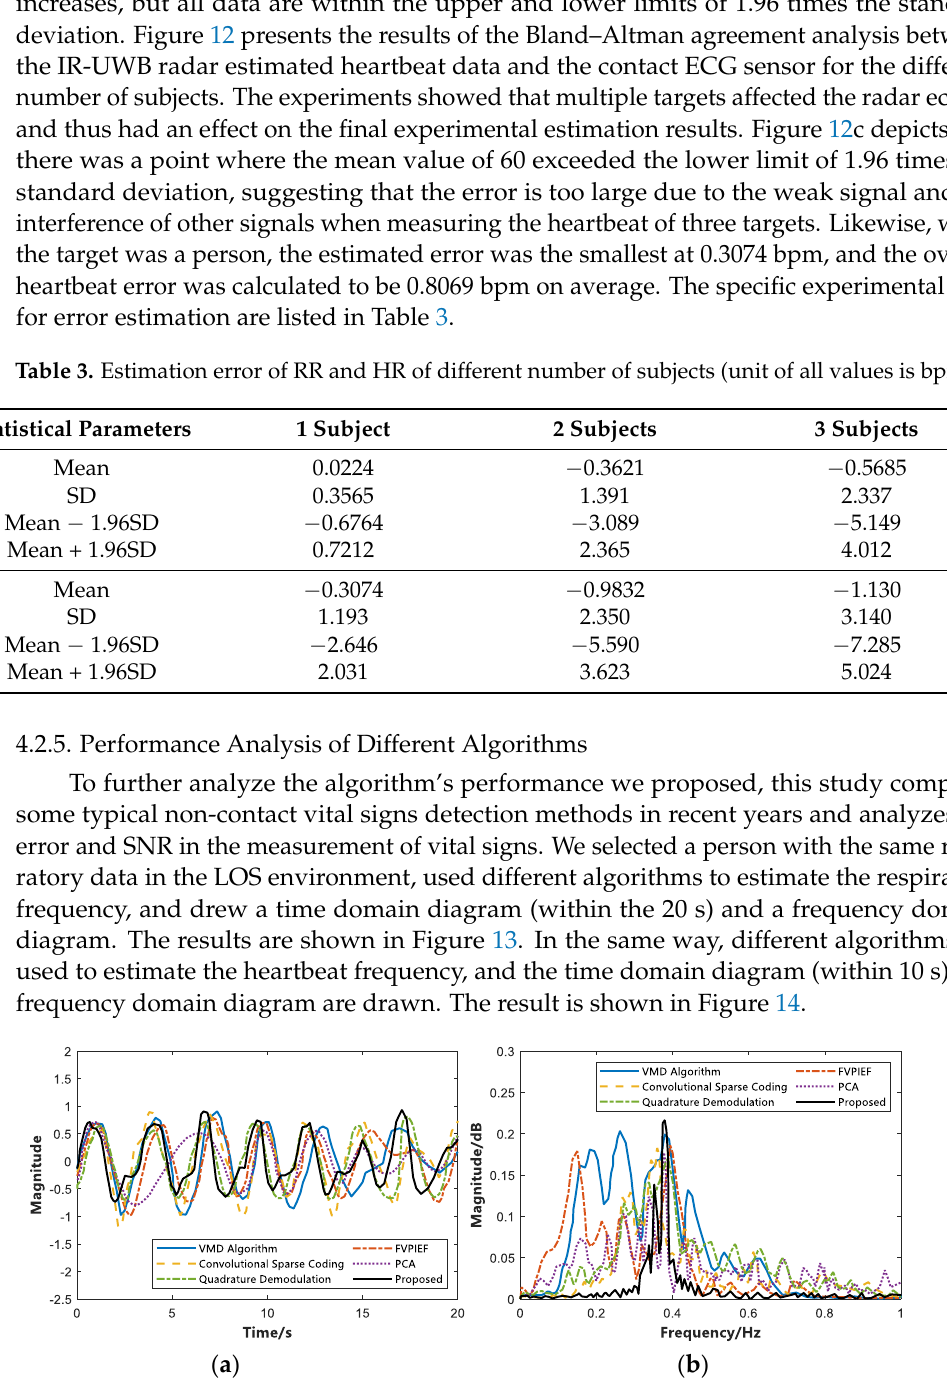
( b ) Figure 14. Time domain and frequency domain of heartbeat estimation using different algorithms. ( a ) Time domain diagram of heartbeat estimation. ( b ) Frequency domain diagram of heartbeat esti- mation. Table 4 lists the error estimation and SNR when different algorithms are used for vital signs. The proposed algorithm has an average error of 5.14% and 4.87% for breathing estimation and heartbeat estimation, respectively. Compared with the other five algo- rithms, the proposed algorithm reduces the estimated breathing and heartbeat errors by 3.91% and 4.77% on average, while the SNR is increased by nearly 8.75 dB on average. The experimental results suggest that the proposed algorithm achieves high accuracy in de- tecting breathing and heartbeat frequency. Moreover, this study has a high SNR, suggest- ing that the proposed algorithm achieves high robustness and can suppress or eliminate the clutter signal in the IR − UWB radar echo signal. The above analyses and findings are the original intentions of this study. Table 4. Errors and signal − to − noise ratios of different algorithms for estimating vital signs Papers